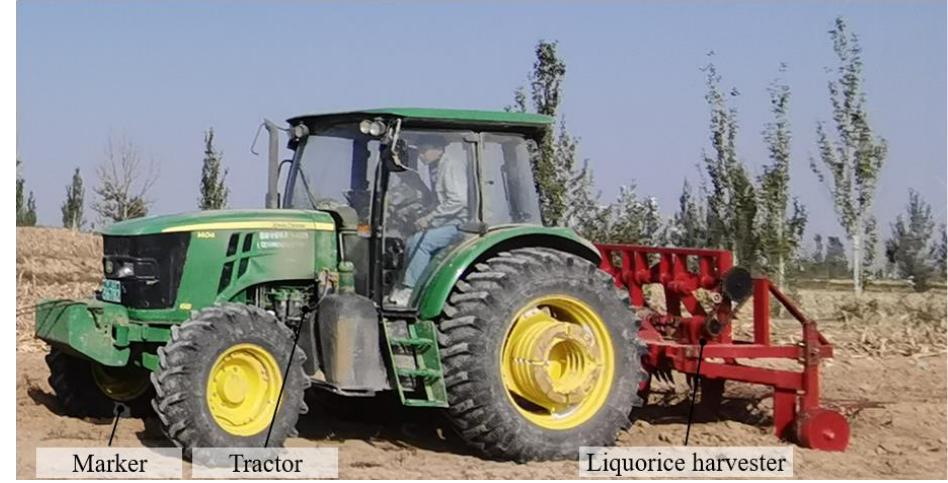
Figure 6. Field test of liquorice harvester.